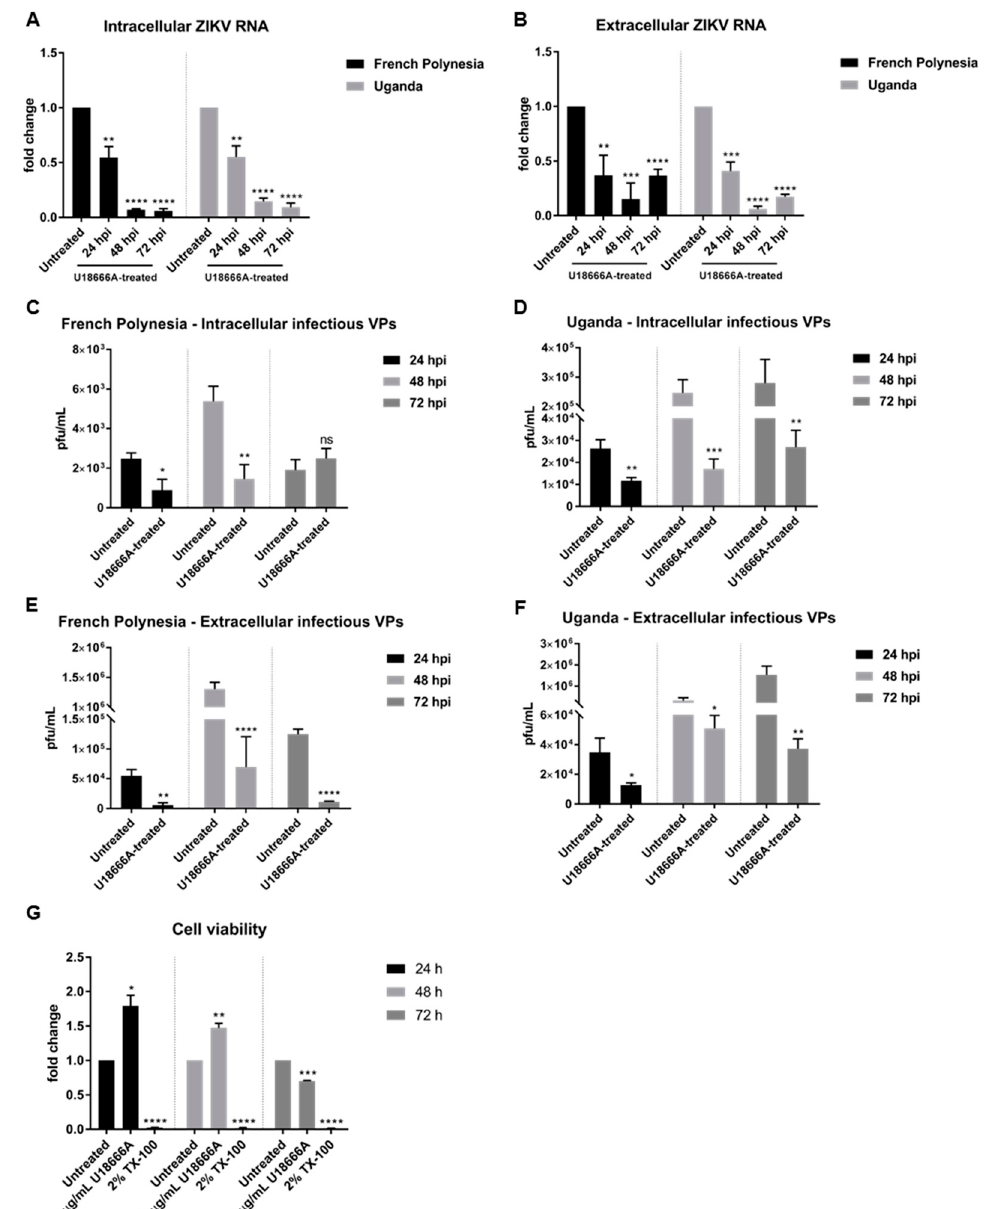
Figure 6. U18666A decreases ZIKV infection in A549 cells. ( A ) Quantification of the amount of intracellular ZIKV RNA of A549 cells infected with either the French Polynesia or the Uganda strain and treated with 2 µ g / mL U18666A (post-infection treatment) during the indicated times. Quantification was performed by RT-qPCR and the amount of ZIKV RNA was normalized to the amount of the RPL27 transcripts. Infected untreated cells were used as control; ( B ) Quantification of the amount of extracellular ZIKV RNA of A549 cells infected with either the French Polynesia or the Uganda strain and treated with 2 µ g / mL U18666A (post-infection treatment) during the indicated times. Quantification was performed by RT-qPCR and infected untreated cells served as control; ( C,D ) Quantification of the number of intracellular infectious viral particles (VPs) from A549 cells infected with either the French Polynesia ( C ) or the Uganda ( D ) strain and treated with 2 µ g / mL U18666A (post-infection treatment) during the indicated times. Quantification was performed in Vero cells by plaque assay and the number of infectious viral particles is expressed in plaques forming units per mL (pfu / mL). Infected untreated cells were used as control; ( E,F ) Quantification of the number of extracellular infectious viral particles (VPs) from A549 cells infected with either the French Polynesia ( E ) or the Uganda ( F ) strain and